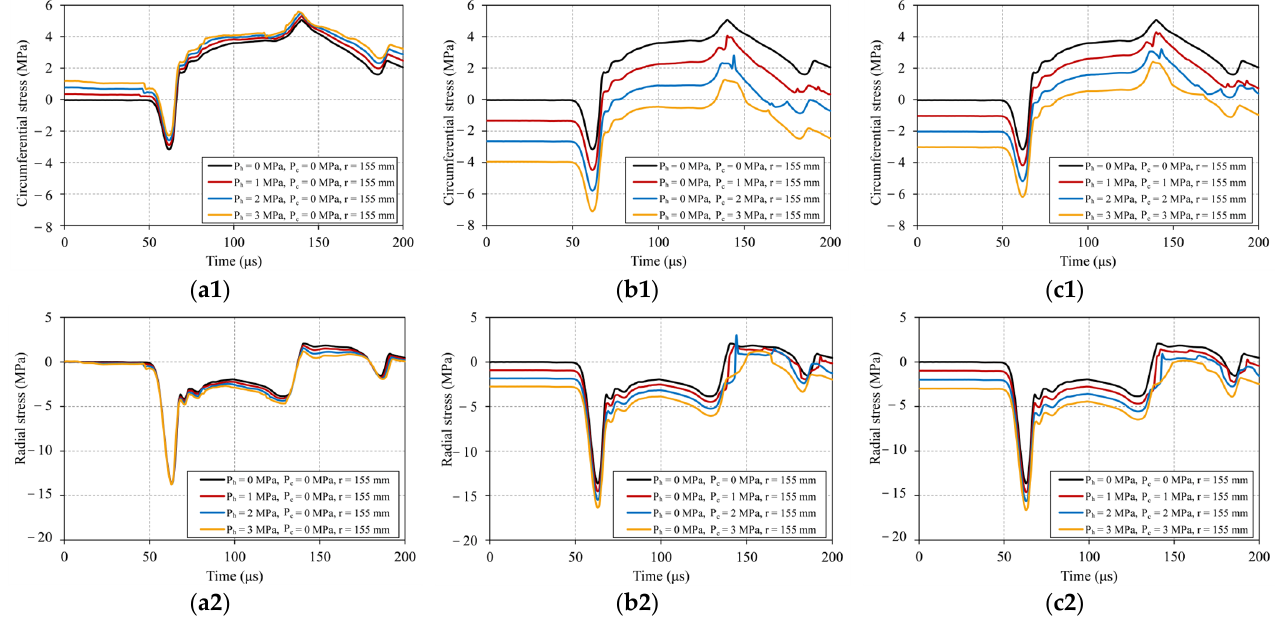
Figure 11. Circumferential and radial stresses at different P h and P c when r = 155 mm. Case 1: ( a1 , a2